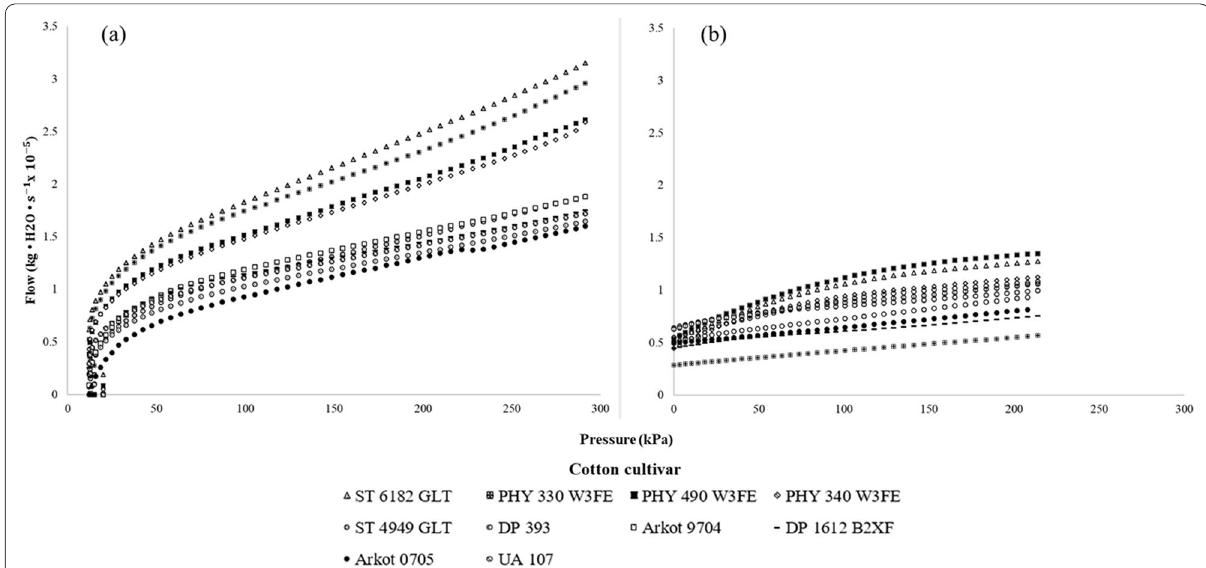
Fig. 2 Average water flow of each cotton cultivar over the total average increase in pressure from each measurement in a Experiment 1: [38 °C, vapor pressure deficit (VPD) > 3 kPa] and b Experiment 2: (32 °C, VPD